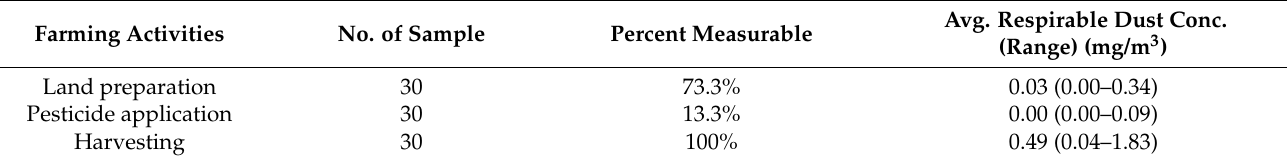
Table 5. Summary of personal respirable dust concentrations (mg/m 3